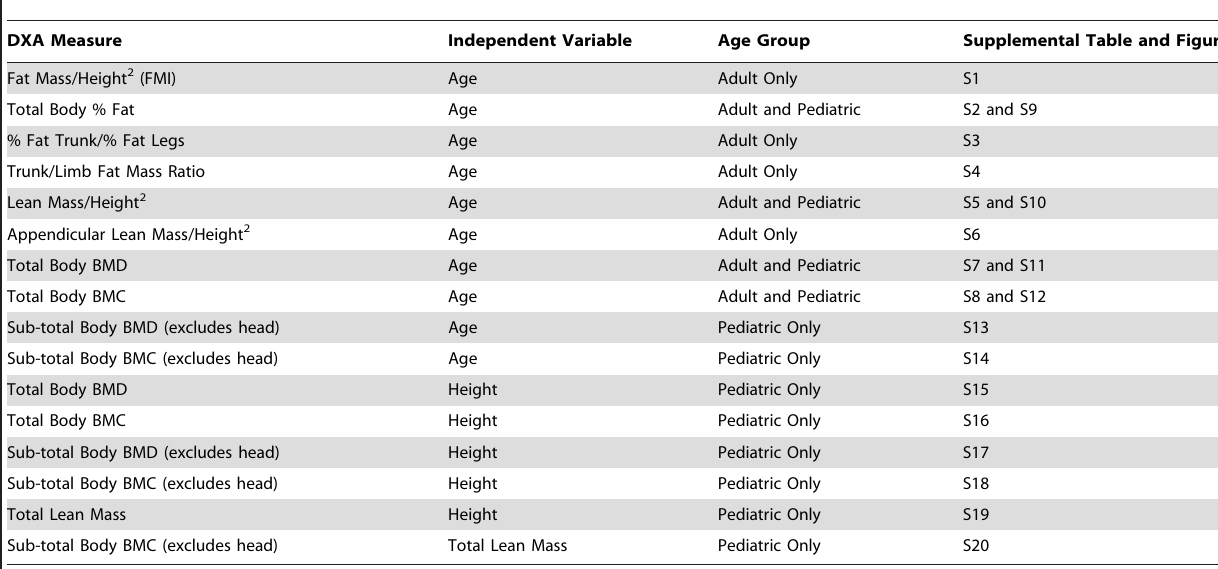
Table 2. List of reference curves generated from the 2008 NHANES DXA whole body data set.